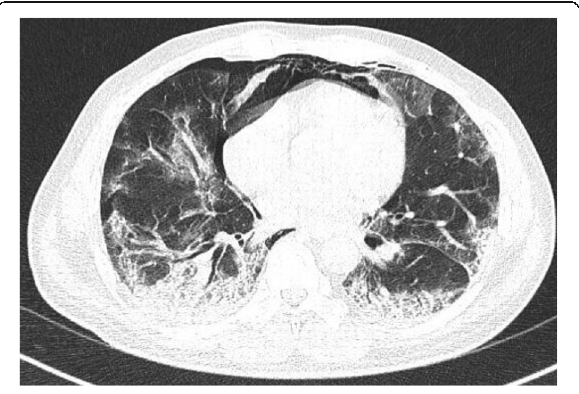
Fig. 10 CT scan thorax lung window showing small right sided pneumothorax, pneumomediastinum, surgical emphysema and lung parenchymal lesions typical of nCovid19